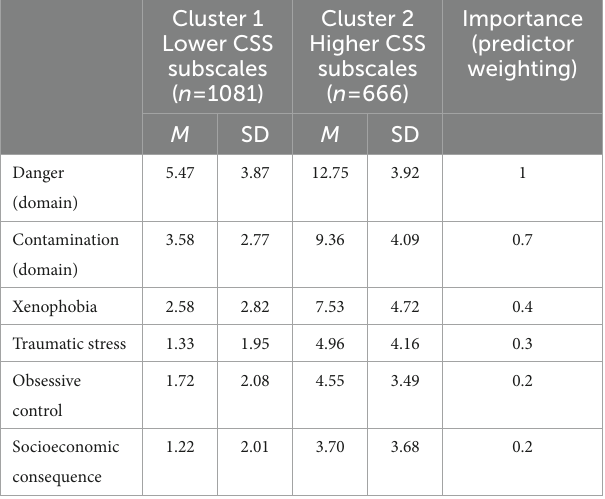
data divided by cluster classification. Figure 1 illustrates WHOQL- BREF, BFI-10, and PHQ-4